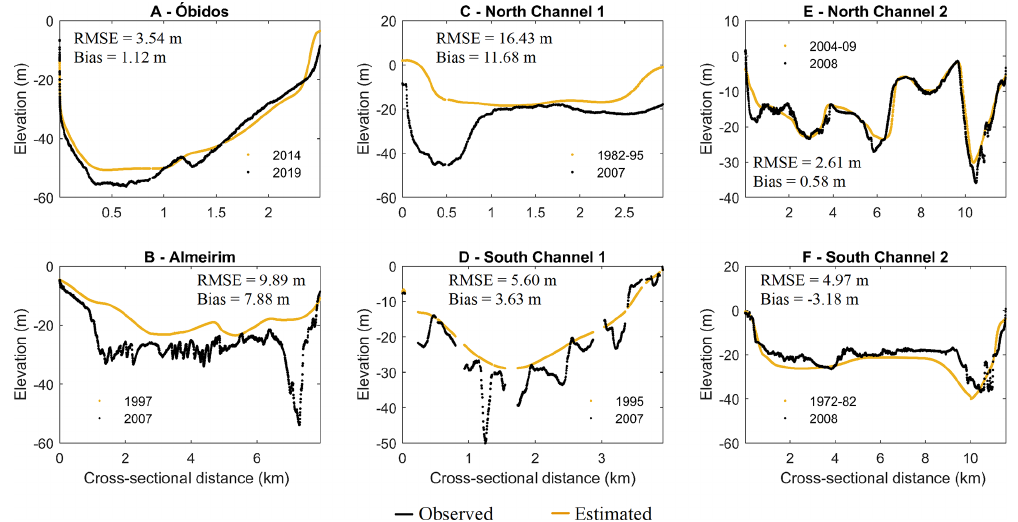
Figure 6. Cross-sectional transects of the Amazon River (locations are shown in Fig. 1) from the cross section estimated (yellow) and observed from the in situ surveys (black). Elevations are relative to EGM08. The dates of the corresponding in situ surveys are indicated in each